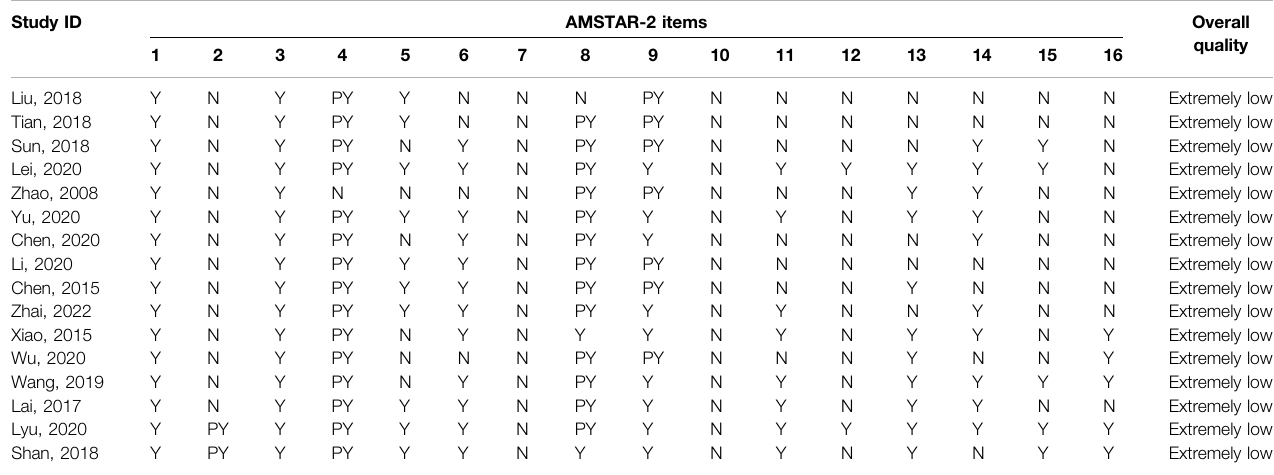
TABLE 5 | Results of the AMSTAR 2